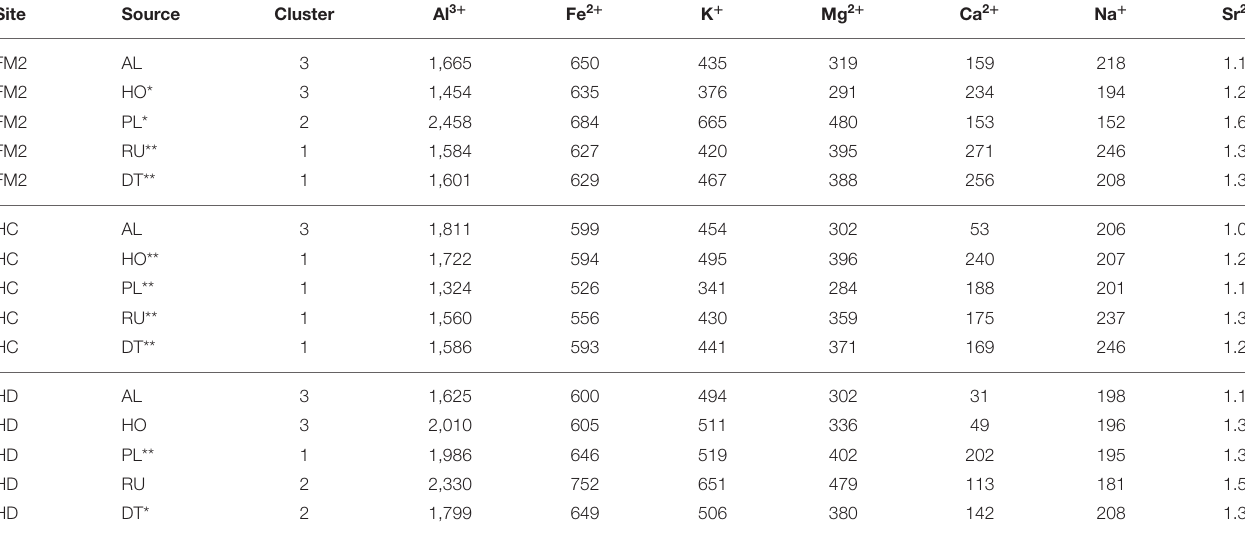
TABLE 3 | Geochemical composition of sediments, measured by ICP-MS. Concentrations are reported in µ mol g − 1 of dry